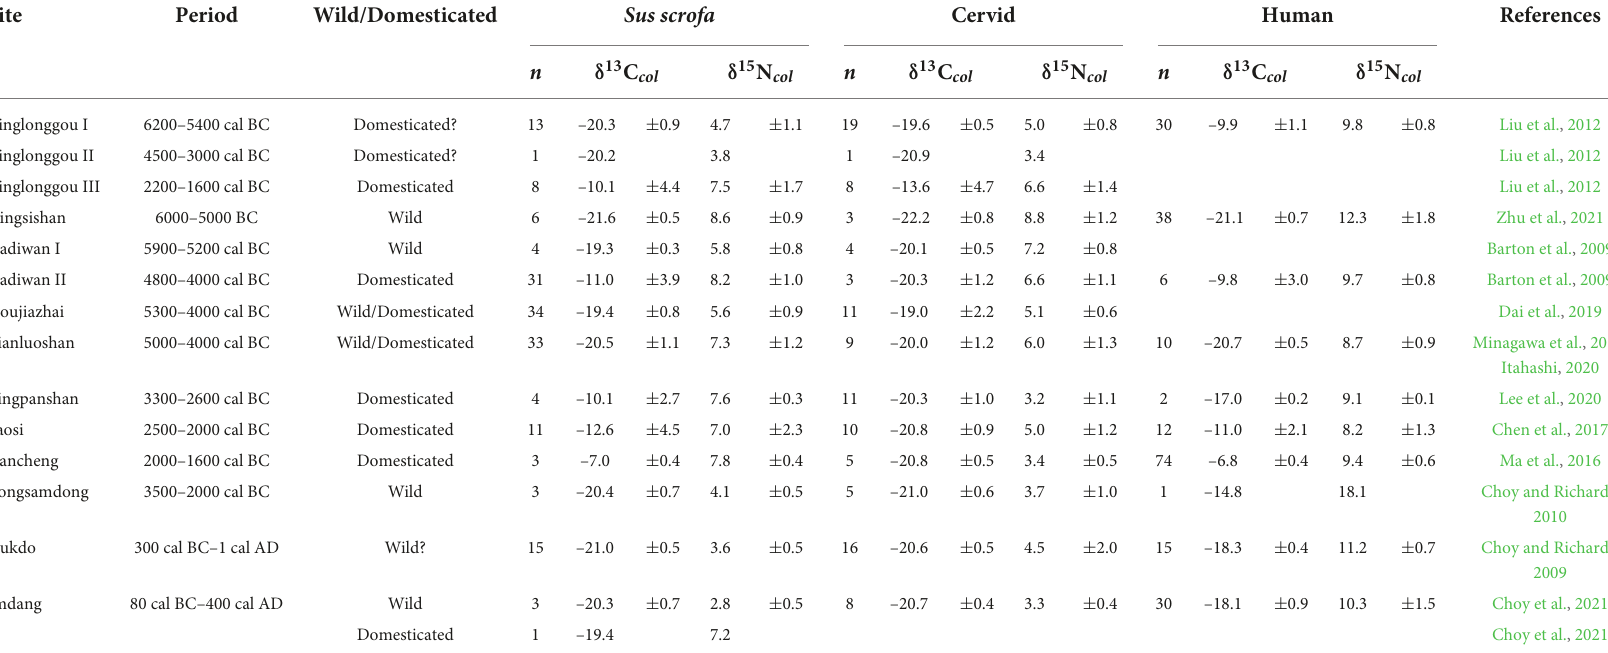
TABLE 1 Carbon and nitrogen isotopic compositions of bone collagen for Sus scrofa , Cervid, and humans at prehistoric sites in China and